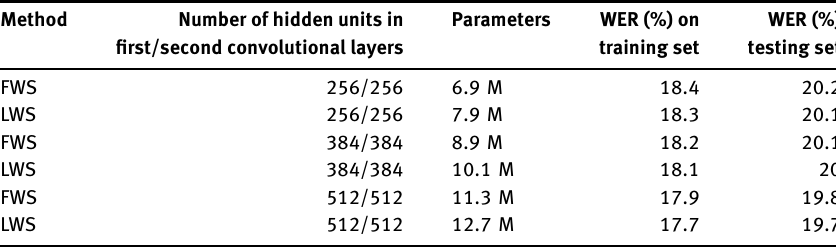
Table 1: WER as a Function of Limited Weight vs. Full Weight